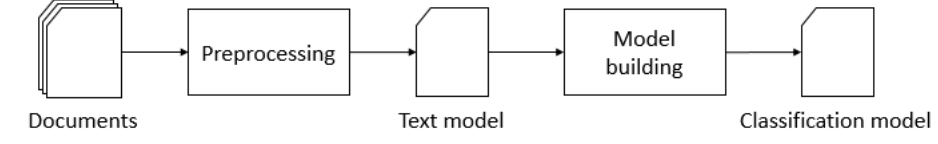
Figure 1. Sequential model building.